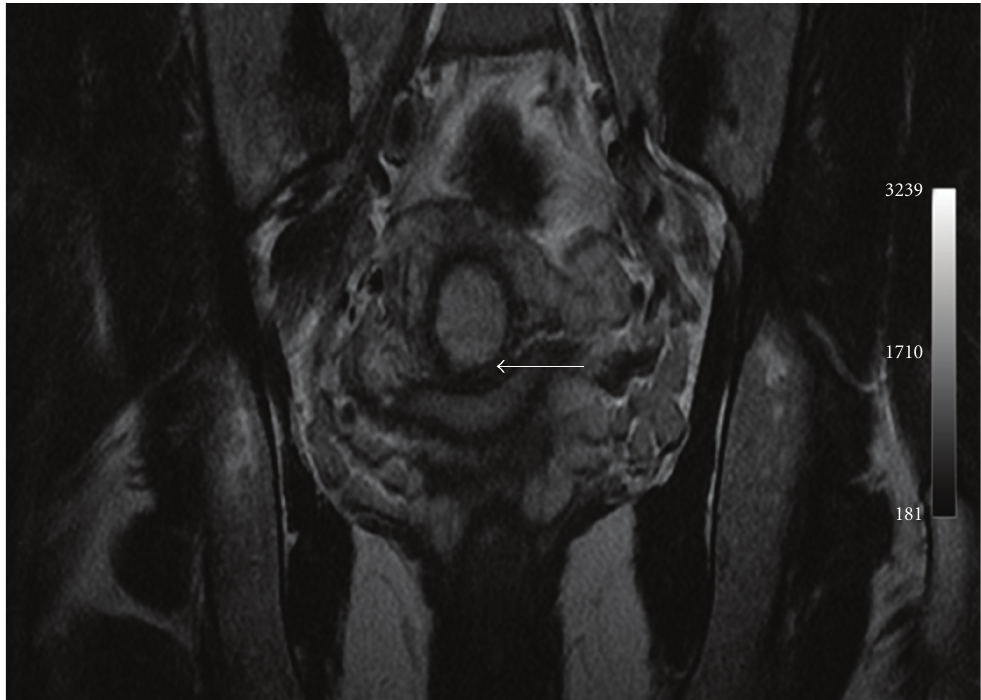
Figure 5: Magnetic resonance imaging gestational sac surrounded by myometrium (arrow head), absence of myometrium between the gestational sac and the bladder